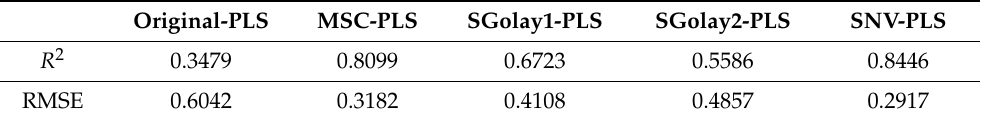
Table 4. PLS prediction models performance for K nutrient of the different pretreatment methods.